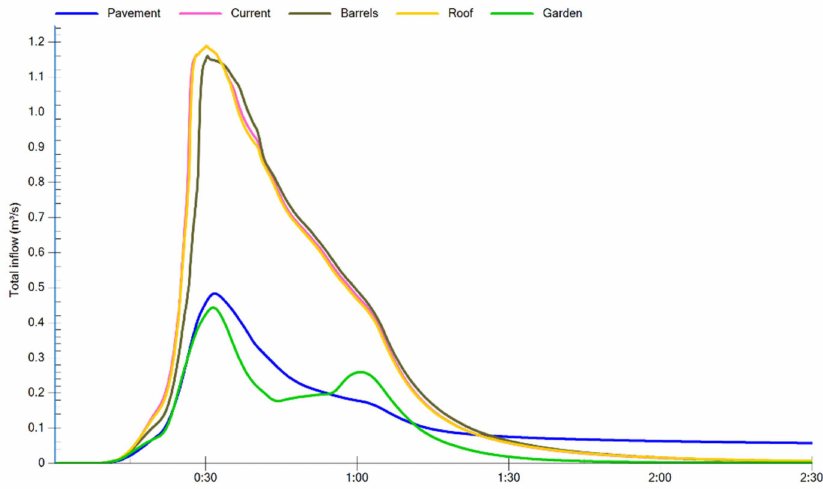
Figure 4. Single BMP implementation